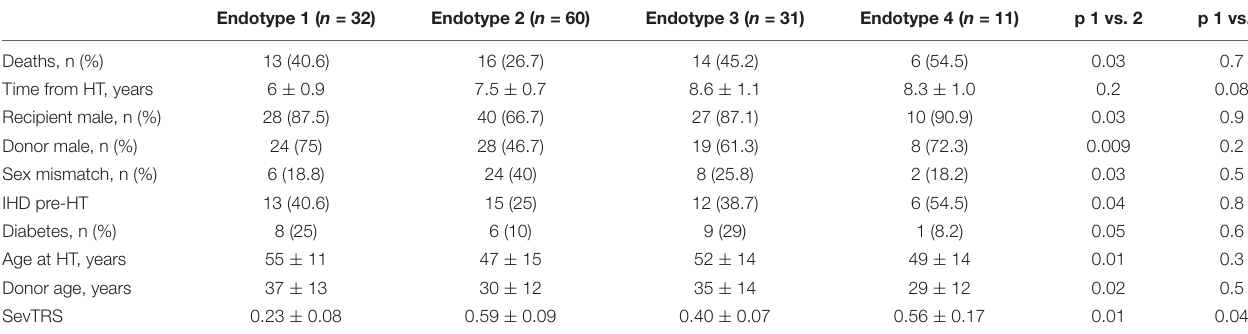
TABLE 3 | Clinical characteristics in different